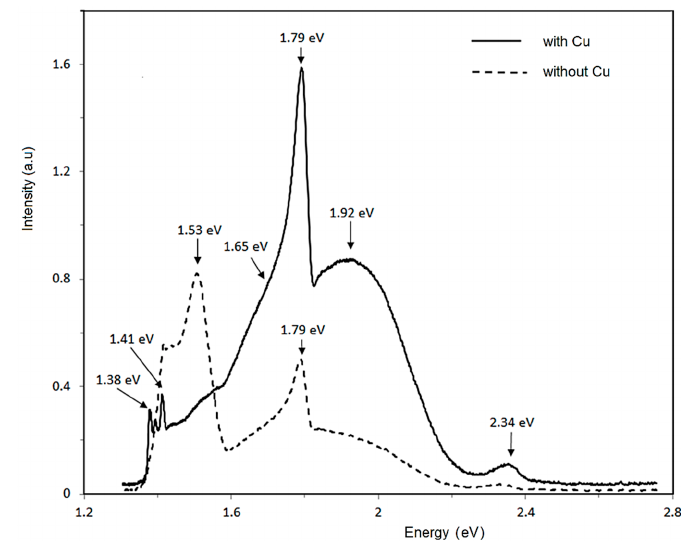
Figure 6. Front side luminescence (10 K) from Cu-doped (solid line) and undoped (dotted line) CdS/CdTe solar cells excited by the 405 nm line.